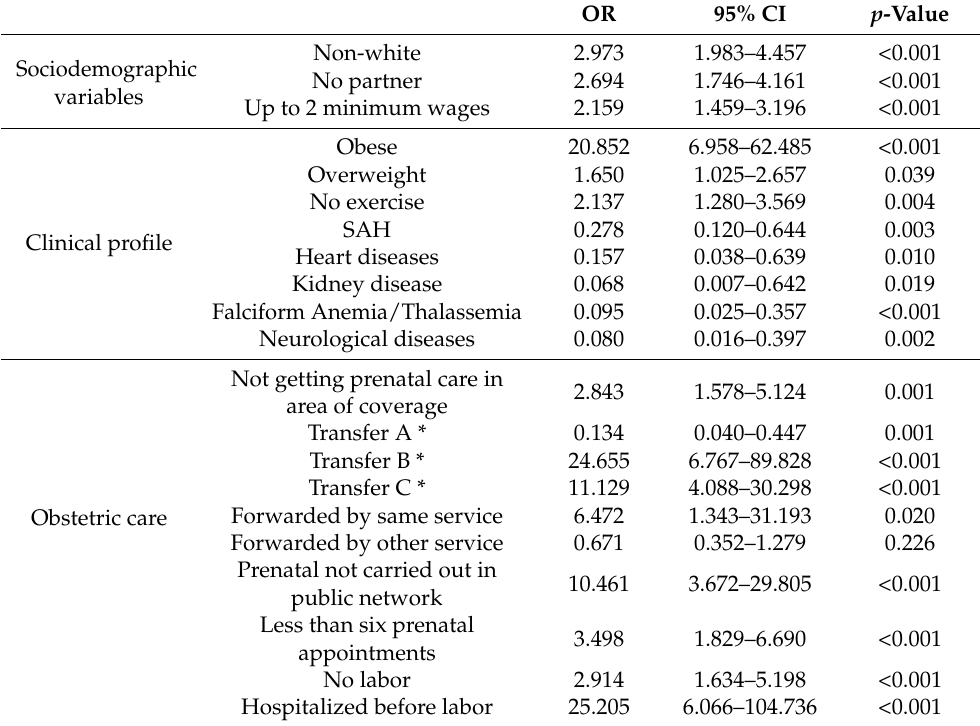
Table 4. Results from the multiple hierarchical logistic regression model. Bras í lia, Federal District,